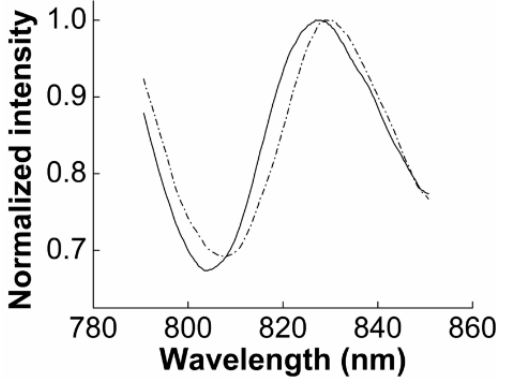
Figure A1. SPR response before (solid line) and after (dashed line) immobilizing the antibody CD44 on the gold nansilt. The shift in Wavelength of SPR resonance indicates the antibody coating on the gold